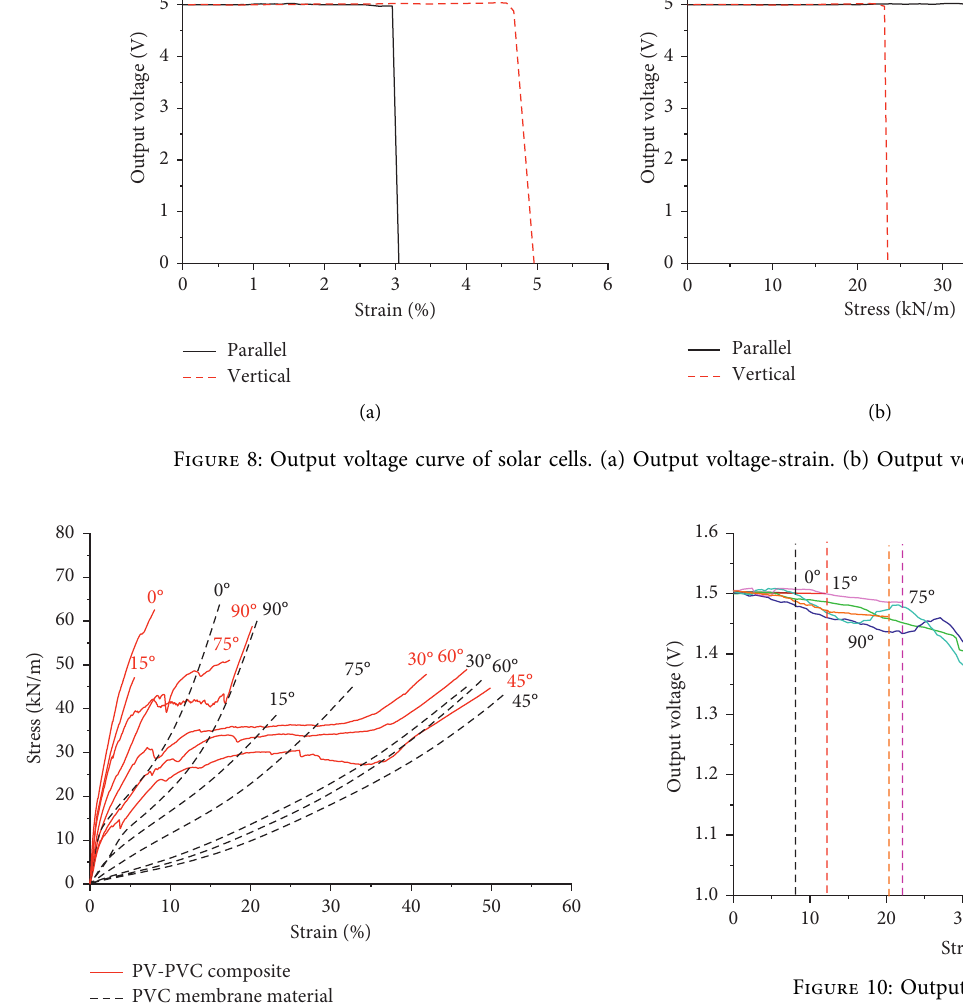
Figure 10: Output voltage-strain.